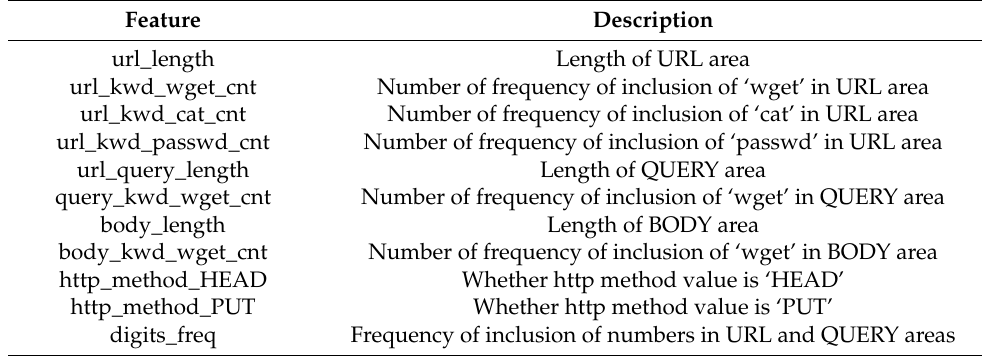
Table 2. Some of the feature frequency (Table 1) by attack type and length content depending on the payload field